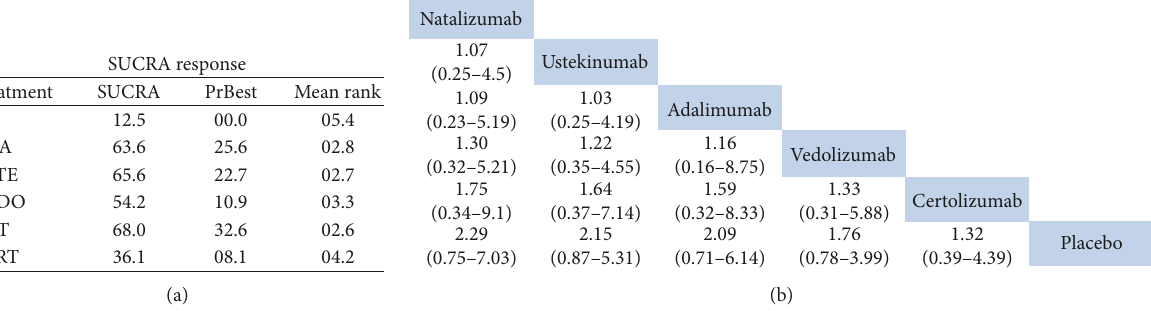
Figure 6: Network meta-analysis and ranking of treatments for inducing response in anti-TNF-experienced CD patients via (a) SUCRA analysis and (b) league table graph. Odds ratios (ORs) with 95% con fi dence interval (CI) are reported. ADA=adalimumab; USTE=ustekinumab; VEDO=vedolizumab; NAT=natalizumab; PL